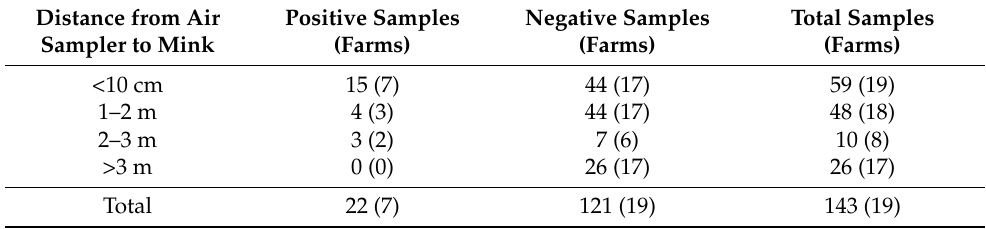
Table 4. Results of PCR analyses of SARS-CoV-2 in air samples collected in 16 Danish mink farms at varying